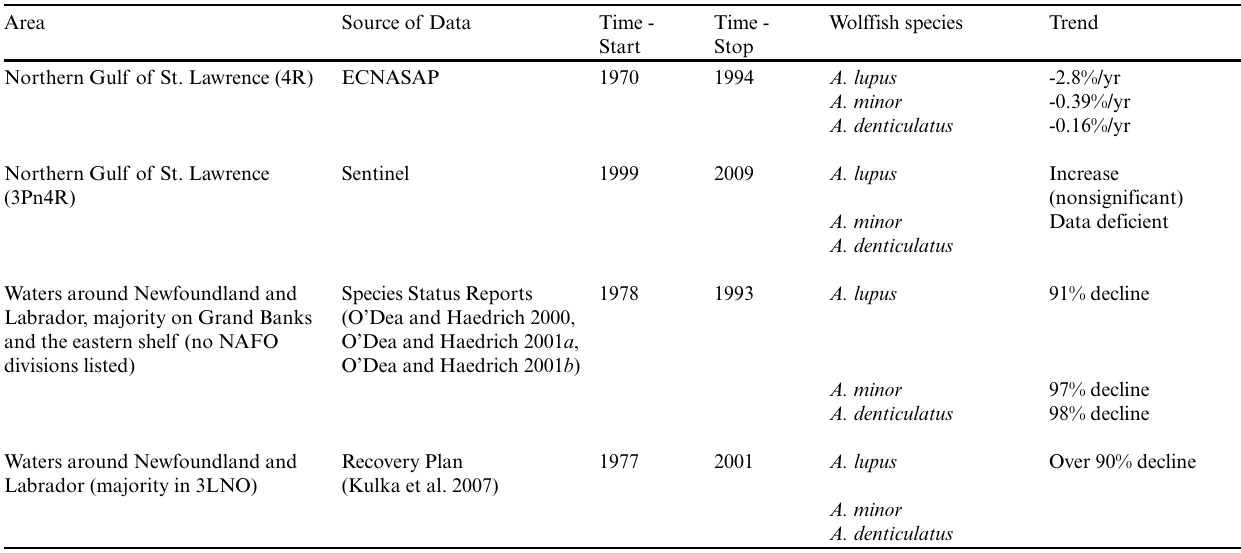
Table 1 . Trends in catch rates of Anarhichas lupus, A. minor, and A. denticlatus by area surveyed, fisheries data source, and time